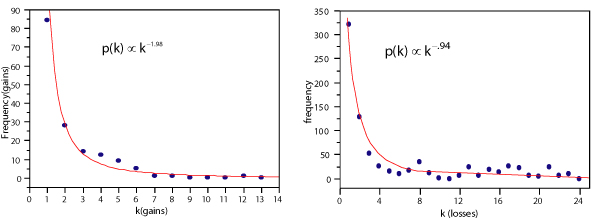
Connectivity distributions for gains and losses of proteins. Left panel: The connectivity distribution for genes at the time they enter the network. Based upon 174 genes that evolved after the root of the tree, and accounting for 395 new connections in the network (mean = 1.91 ± 1.77). Curve accounts for 95% of the variance in connectivity frequencies. Right panel: The connectivity distribution of genes at the time they were lost from the network. Curve accounts for 89% of the variance in frequencies. Based upon 239 genes comprising 847 losses or 3.54 ± 2.37 losses per protein (a protein can be lost in more than one place on the tree).